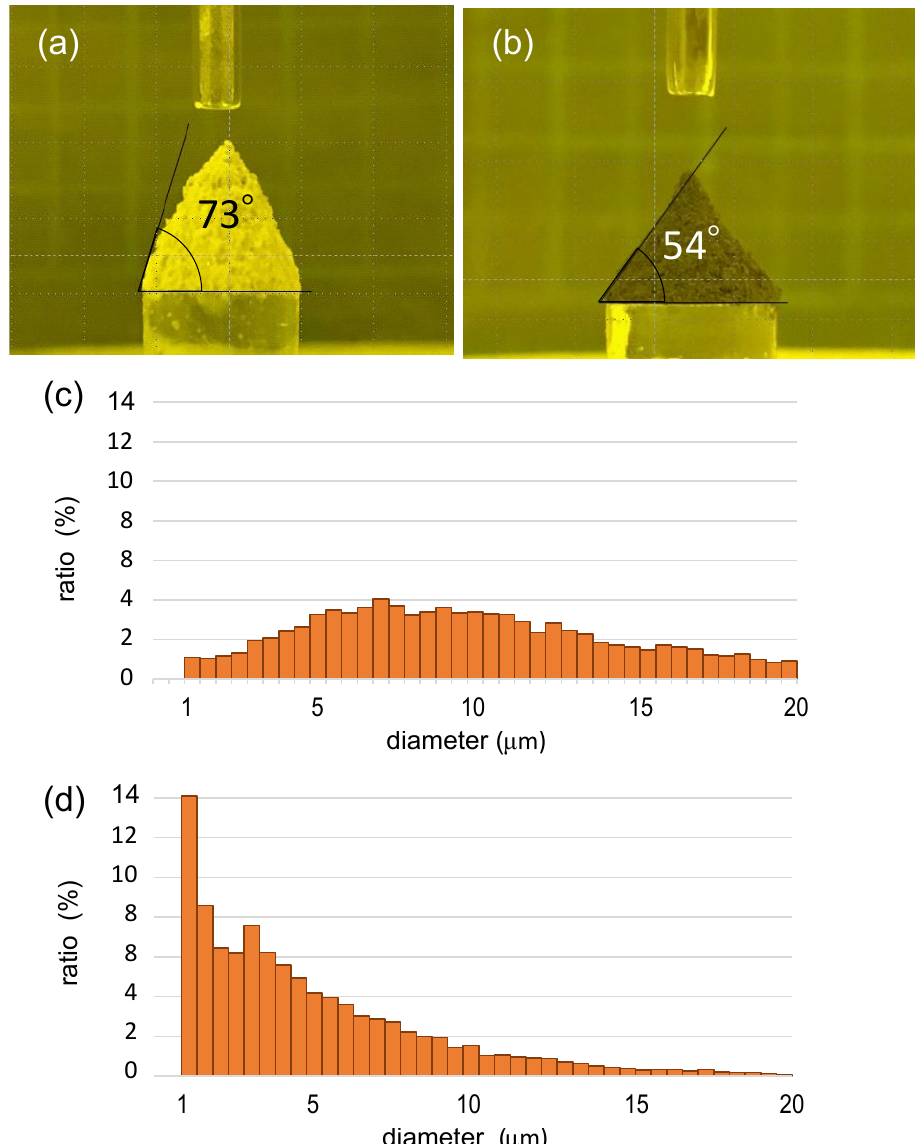
Figure 1. Photograph of the repose angle estimation for Ag toner particles ( a ) and Ag–Ni composite particles ( b ). Histogram of the particle size distribution for the bare Ag particles ( c ) and Ag–Ni composite particles ( d ),